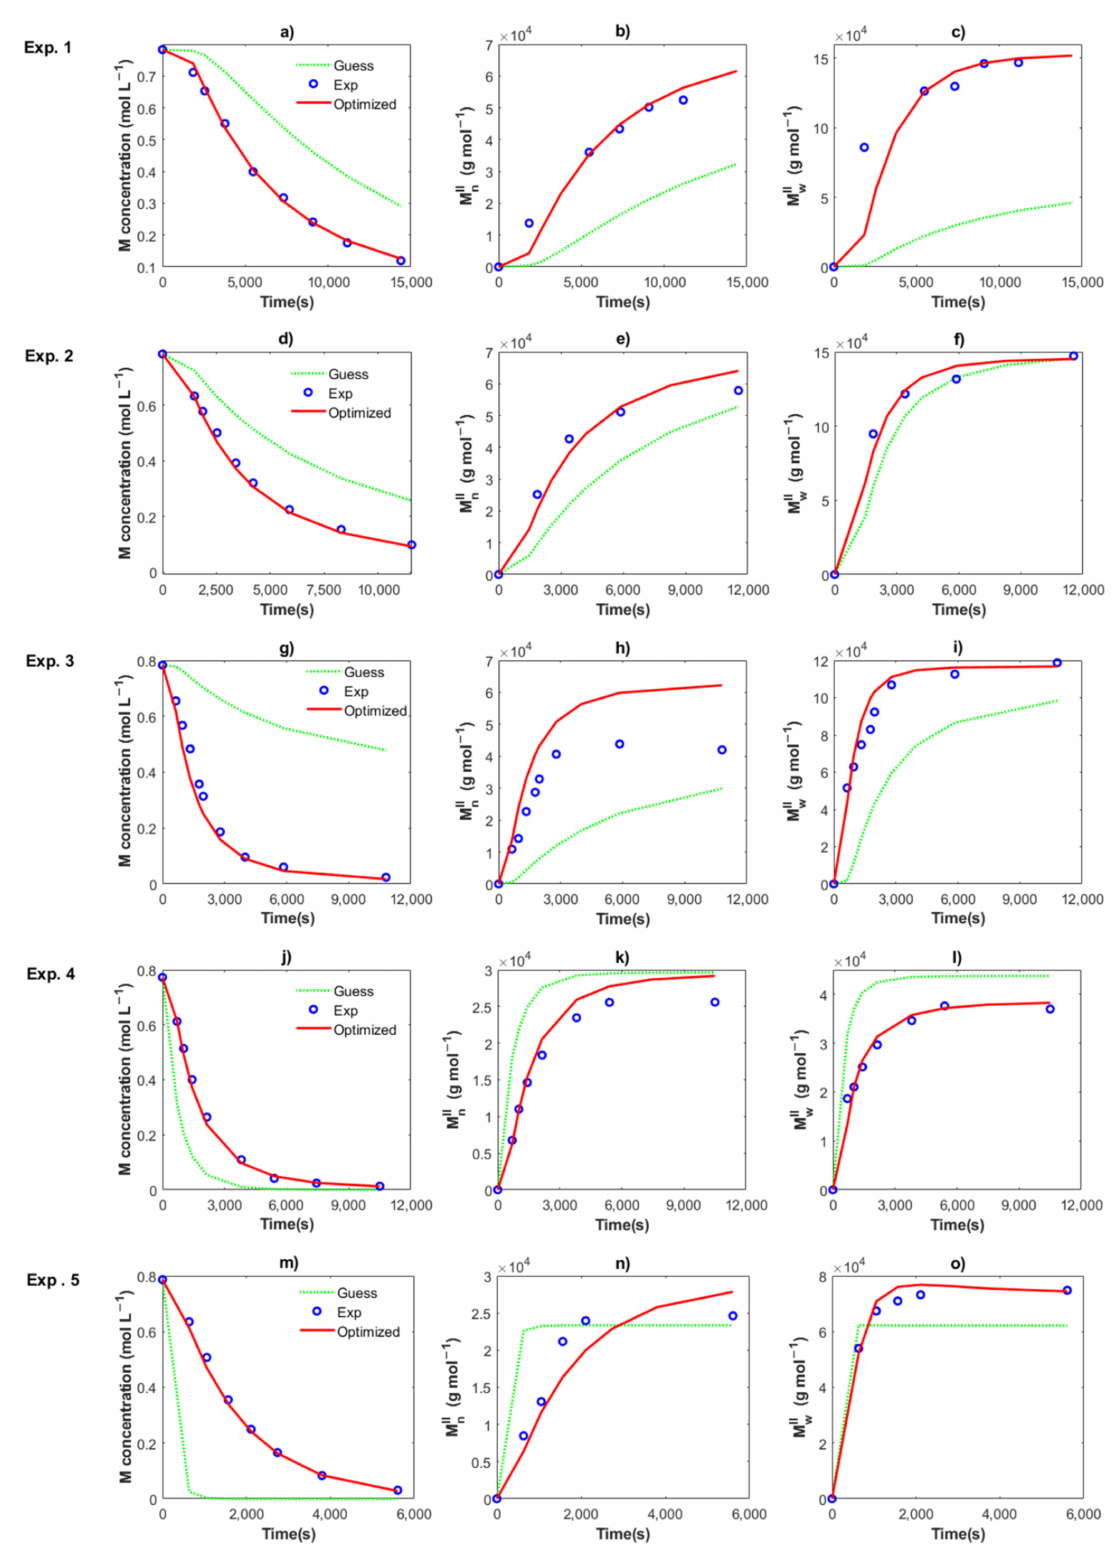
Figure 6. Comparison between the experimental data (circles), the solution using the guess values (dotted lines) and the solution using the optimized values (red lines) for Exps. 1 ( a – c ), Exps. 2 ( d – f ), Exps. 3 ( g – i ), Exps. 4 ( j – l ), and Exps. 5 ( m – o ). Remaining monomer ( a , d , g , j , m ), M n ( b , e , h , k , n ) and M w ( c , f , i , l , o